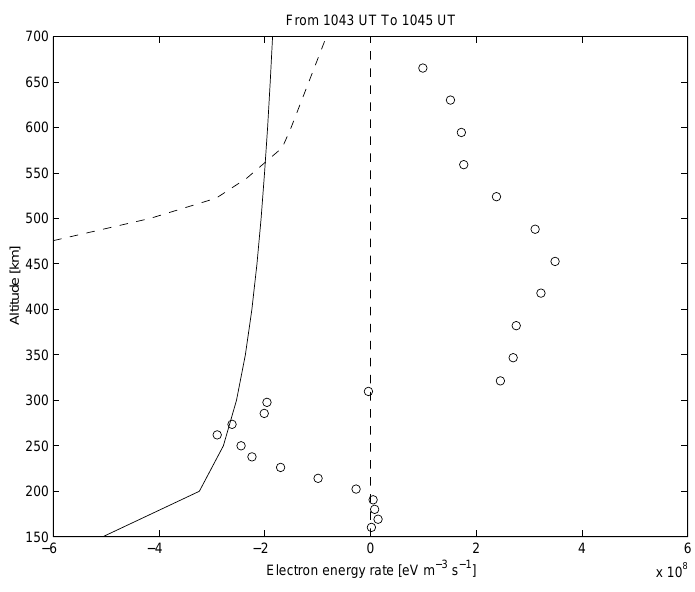
Fig. 6. Contributions from photoelectrons (dashed line), heat conduction (solid line) and advection (circles) to the total heat flux on 1999- 07-08, from 10:43 until 10:45UT.